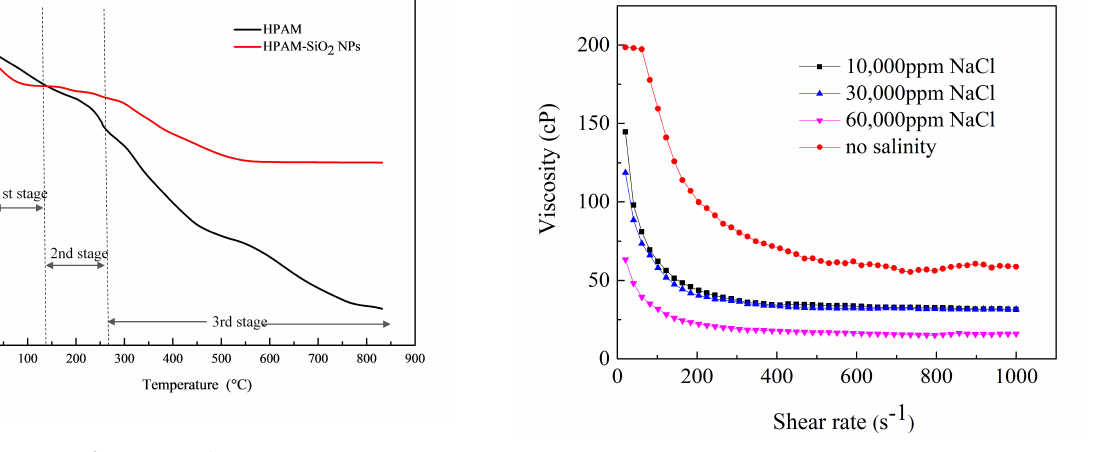
Fig. 8. Shear viscosity of HPAM at different concentration of NaCl at 25°C.